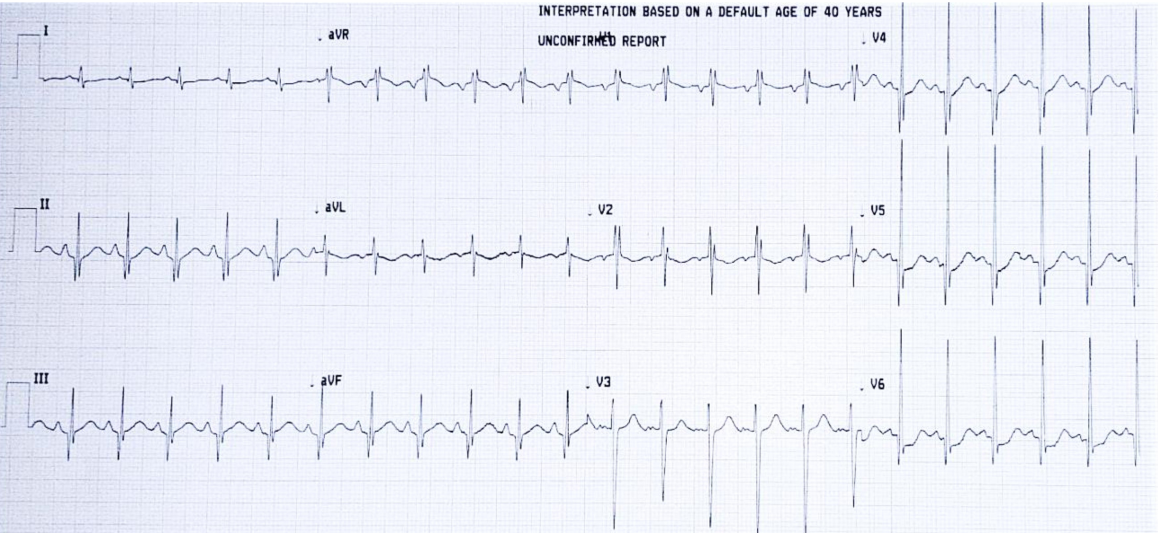
Figure 3. ECG showing pathological Q waves in DII, DIII, aVF, V4–V6, 2 mm depression ST segment in V5–V6, negative T waves in DI, aVL, suggestive of ischemia, lesion, and necrosis.